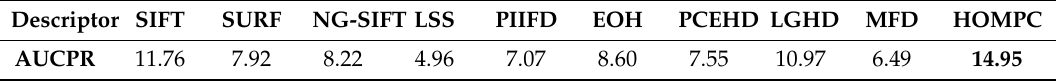
Table 6. AUCPR (%) results for all the